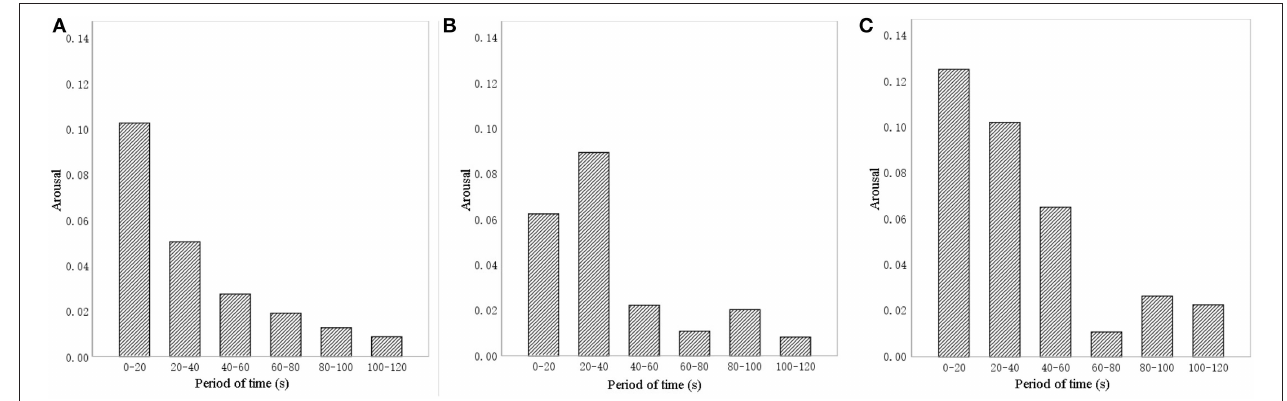
FIGURE 2 | Pilot study results for arousal by the different sound interventions. (A) Music, (B) stream, and (C) birdsong.